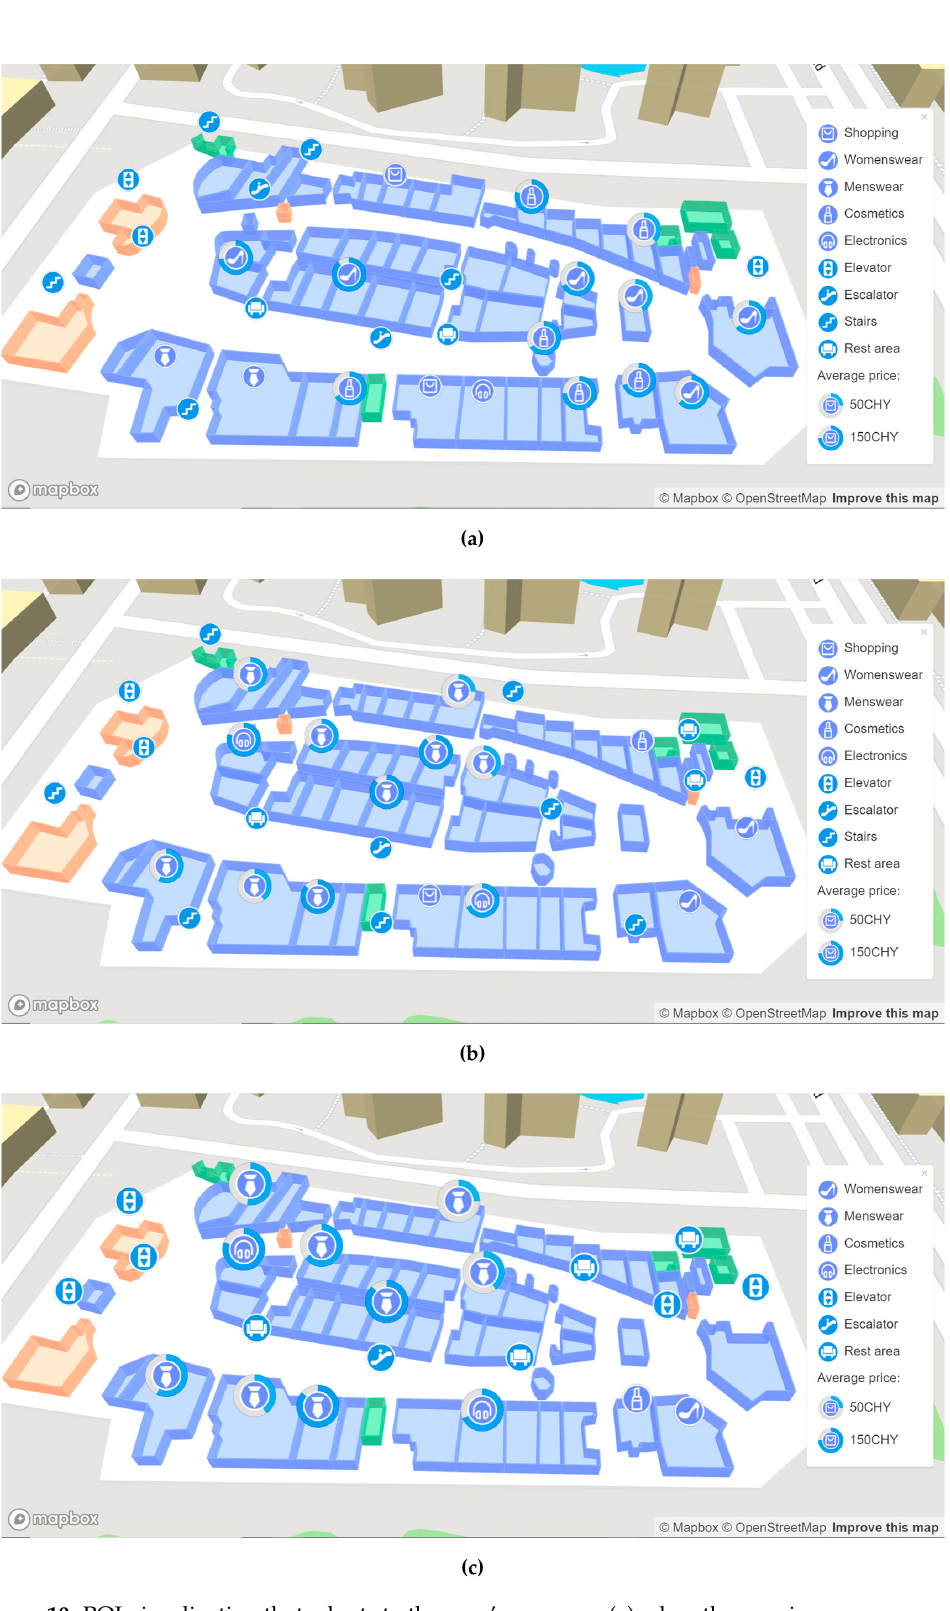
Figure 10. POI visualization that adapts to the user’s purpose: ( a ) when the user is a young woman whose purpose is to shop for cosmetics and women’s clothes; ( b ) when the user is a young man whose interests lie in shopping for electronics and men’s clothes; ( c ) when the user is an older man with the same interests as the young man in ( b